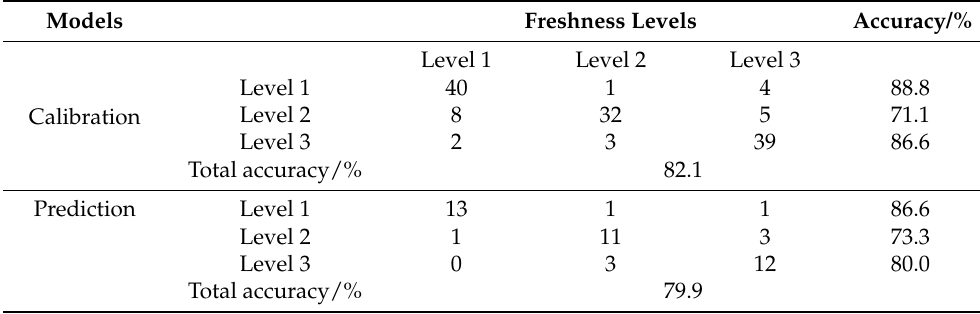
Table 4. Accuracy of classification models of freshness levels in mini-Chinese cabbage by PLS-DA.